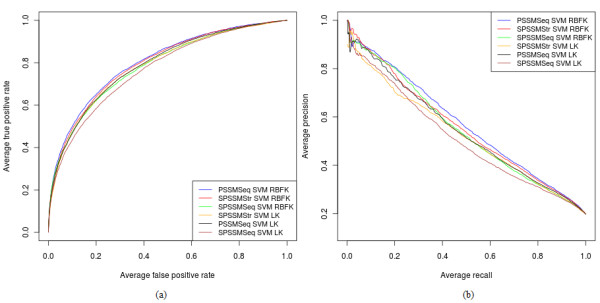
A comparison of the performance of the Support Vector Machine (SVM) classifier with a radial basis function (RBF) kernel on 3 different structure datasets using the PSSMStr feature. (a) ROC curves and (b) PR curves showing the comparison of the performance of the SVM classifier with an RBF kernel using the PSSMStr feature on RB106Str, RB144Str, and RB198Str datasets.